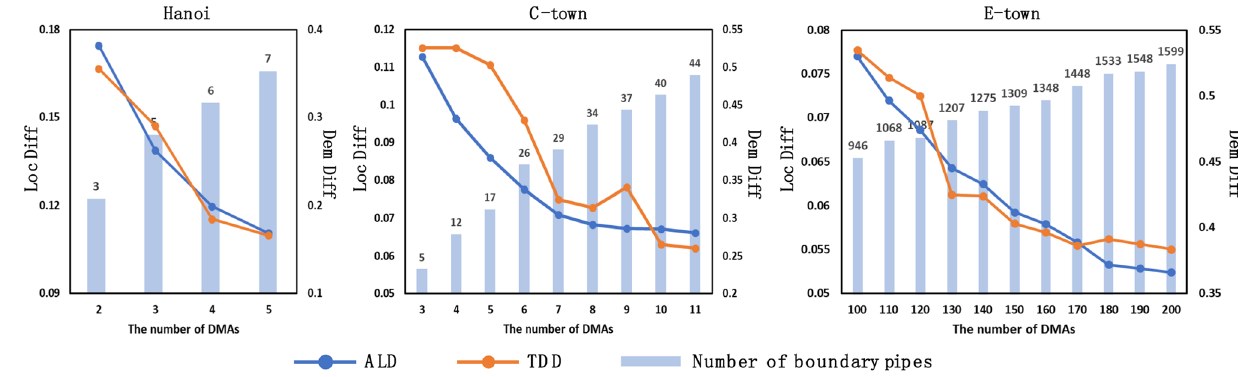
Fig. 5 Influence of number of DMAs on LocDiff, DemDiff, and boundary pipe’ number in the networks of Hanoi (left), C-town (middle), and E-town (right).